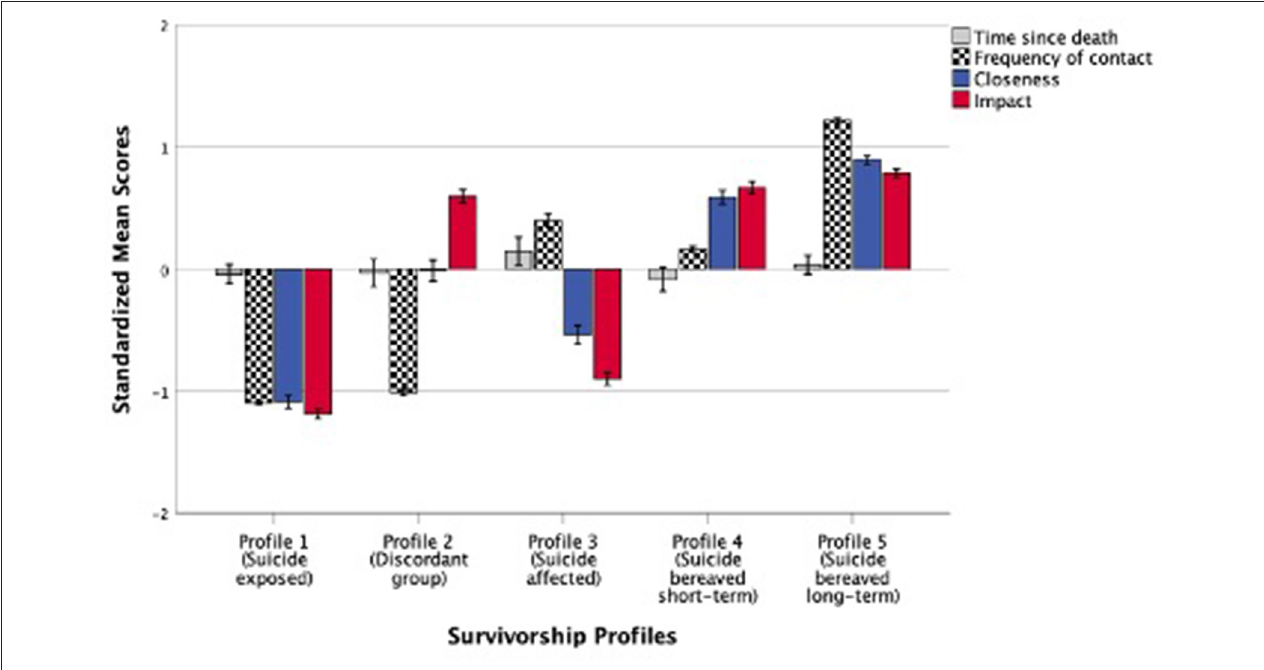
FIGURE 1 | Standardized mean scores ( M = 0 , SD = 1) of suicide exposure risk factors across five survivorship profiles. Error bars represent standard errors (SE) ±